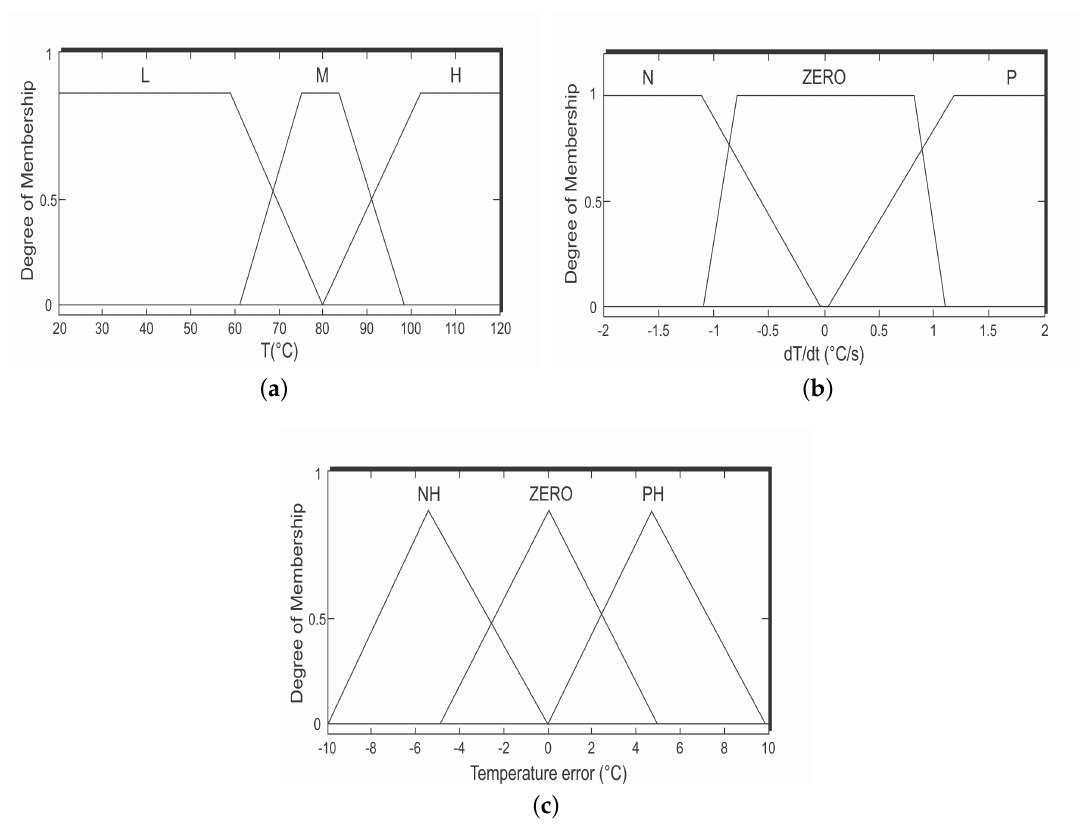
Figure 4. Input fuzzy set membership function for Layer 1: ( a ) input for collector temperature; ( b ) input for derivative temperature in the storage tank; ( c ) input error (reference -current temperature) for the